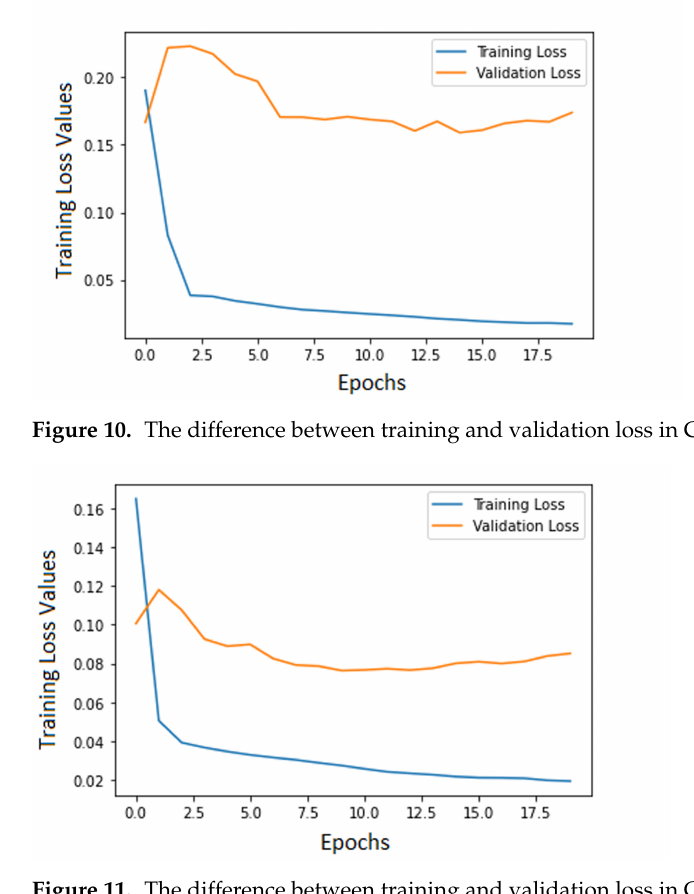
Figure 11. The difference between training and validation loss in Case 2.